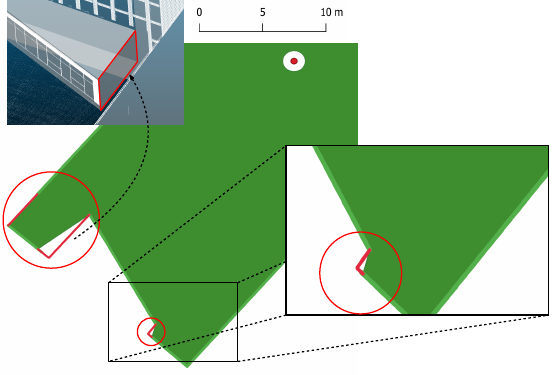
Figure 5. Visibility polygon (green) of the scanner (red point) positioned in the upper right corner of an excerpt of the scene. Red wall elements cannot be observed due to the violation of the incidence angle constraint. The point cloud stemming from this standpoint is accordingly incomplete (upper left).